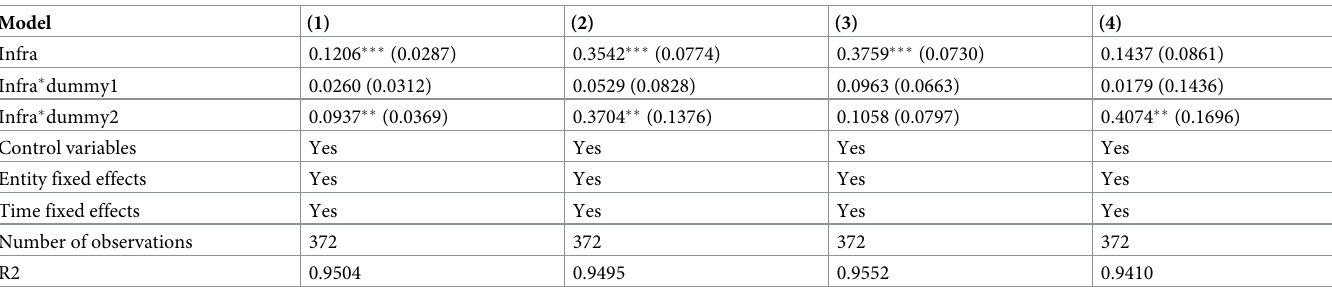
Table 7. Impact of infrastructure on tourism industry competitiveness in diverse regional